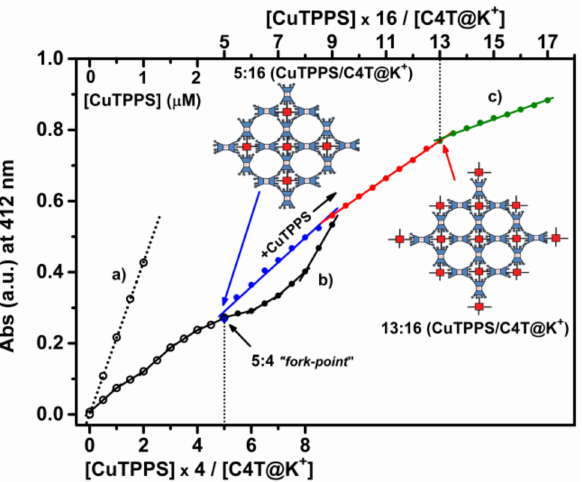
Figure 3. Variation in the absorbance of the CuTPPS Soret band ( λ max = 412 nm) observed upon: (i) increase of the porphyrin concentration in water (dotted black trace labelled as ( a )); (ii) portion-wise addition of CuTPPS to a 2 µ M aqueous solution of C4T @K + at pH 3.0 (solid black trace labelled as ( b )); (iii) initial portion-wise addition of CuTPPS to a 2 µ M aqueous solution of C4T @K + at pH 3.0 up to the formation of the 5:4-( CuTPPS/C4T @K + ) assembly (see the black arrow of trace ( b )), followed by portion-wise addition of C4T @K + (up to a final [ C4T @K + ] = 8 µ M) to form the 5:16- concentration from 2.5 to 8.5 µ M to yield the 17:16-( CuTPPS/C4T @K + ) assembly